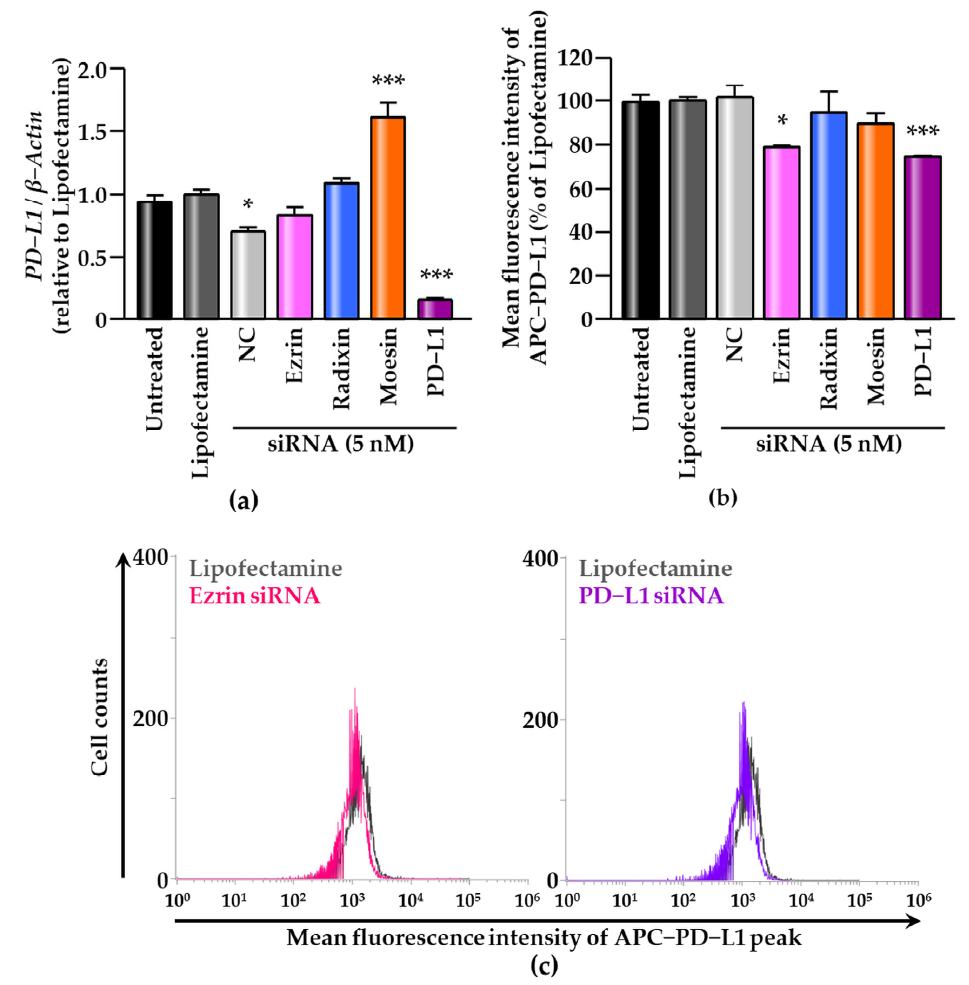
Figure 5. Effects of RNA-mediated interference of ezrin, radixin, and moesin on the expression of programmed death ligand-1 (PD-L1) in HEC-151 cells. ( a ) Relative mRNA expression of PD-L1 normalized with β -Actin was determined via a reverse transcription–polymerase chain reaction. n = 3, *** p < 0.001, * p < 0.05 vs. Lipofectamine. ( b ) The mean fluorescence intensities of allophycocyanin (APC)-labeled PD-L1 relative to Lipofectamine alone; n = 3, *** p < 0.001, * p < 0.05 vs. Lipofectamine. ( c ) Histograms for APC-labeled PD-L1 fluorescence in the surface of HEC-151 cells treated with Lipofectamine (gray), ezrin siRNA (red), and PD-L1 siRNA (purple), as measured by flow cytometry. All data were expressed as the mean ± SEM and analyzed by one-way ANOVA followed by Dunnett’s test. Nontargeting control;